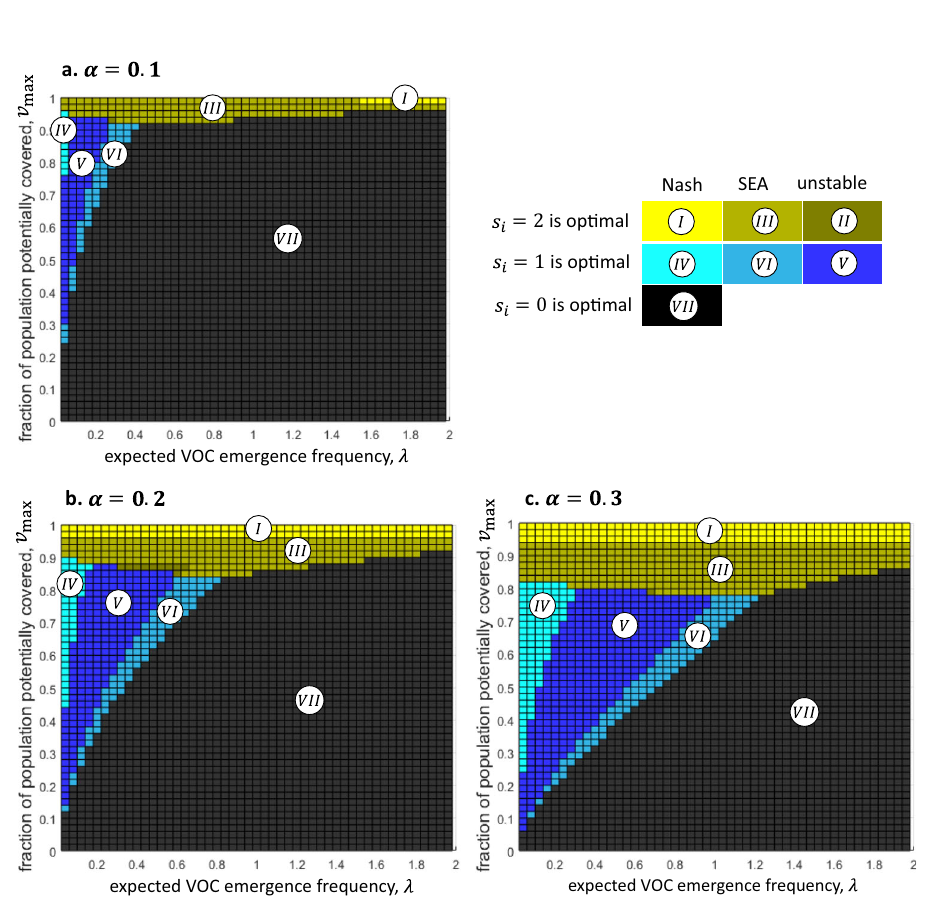
Fig. 3 The optimal solution and its stability across α values. The optimal solution and its stability depend on the values of the parameters v max , λ , and α . Each panel characterizes a different value of α : a α ¼ 0 : 1. b α ¼ 0 : 2. c α ¼ 0 : 3. N ¼ 6 in all panels. Each colored rectangle on the top panel represents the solution for the corresponding values of λ and v max . In regions I , II , and III (yellow shades), s i ¼ 2 by all vaccine-rich countries is optimal. In regions IV , V , and VI (blue shades), s i ¼ 1 by all countries is optimal. In region VII (black), s i ¼ 0 by all countries is optimal. One notable observation is that if α (the unavoidable fraction of the cost of an outbreak, given surplus doses) is smaller, then it is less worthwhile to donate, and the range of parameters that renders donations advantageous is